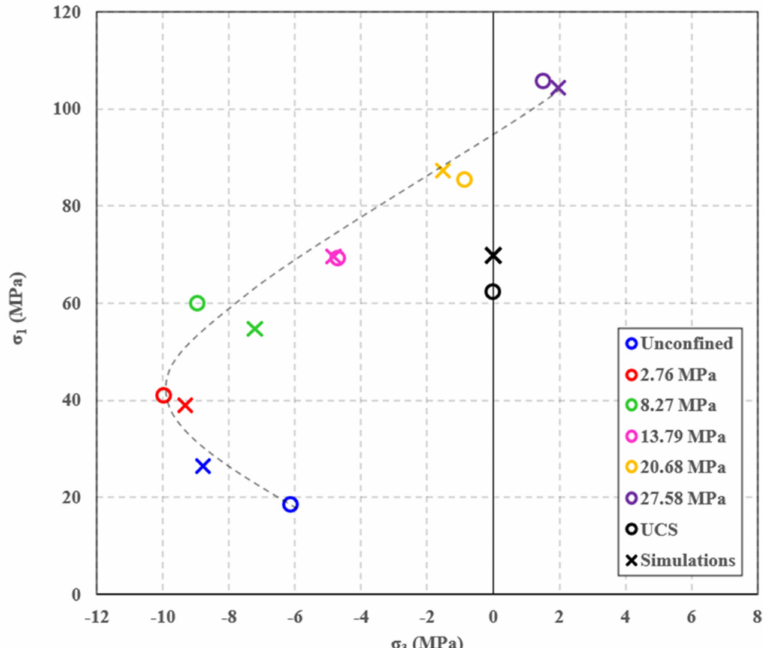
Figure 10. Minimum and maximum principal stresses at failure for the experimental tests and numerical models. Each of the six simulations are represented with X symbols.